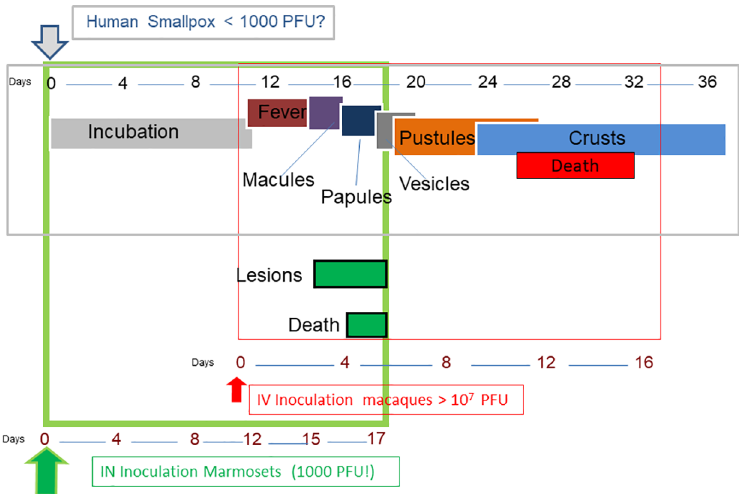
Fig 10. Comparison of the clinical course of smallpox and monkeypox in humans and infected nonhuman primates. To elucidate both the resemblance to human smallpox disease and how our model relates to the “gold standard” of NHP models for poxvirus countermeasures, the figure depicts the human disease (grey outlined box), the IV monkeypox-macaque model (red outlined box) and the IN monkeypox-marmoset model (outlined in green). Arrows are color coded by host and indicate the point of exposure. Days (in the form of a number line) relative to exposure are given for each Human disease manifestations are temporally identical to IN exposed marmosets to include viremia and oral shedding (not shown-see discussion), but fever has not yet been detected in marmosets (IV = intravenous; IN = intranasal). This Figure is a modification of Figure 34 from Mucker, 2014 [36].